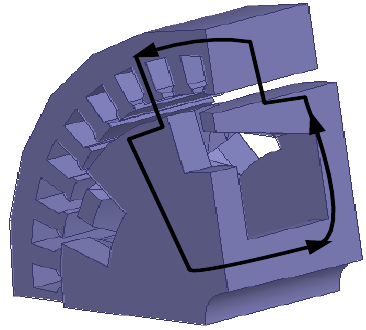
Figure 3. Magnetic circuit of the motor.